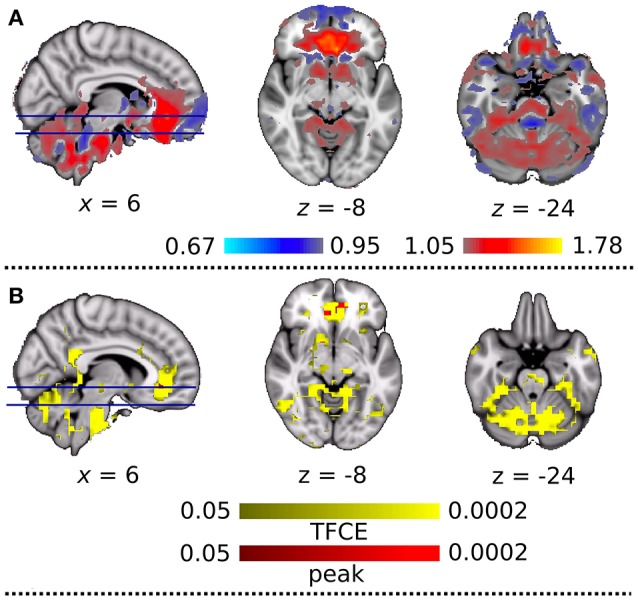
(A) Qualitative comparison map of the ratio of low-frequency to high-frequency signal power (LFHF ratio) between the datasets with and without field map correction. Red and blue indicate greater and lesser LFHF ratio after the correction, respectively. (B) Statistical comparison between LFHF ratio with and without field map correction. Colored clusters indicate significantly increased connectivity after field map correction thresholded by threshold-free cluster enhancement (TFCE) (YELLOW) and thresholded by peak (height)-based method (RED) (both after multiple comparison familywise error correction across voxels and contrast; p < 0.05).